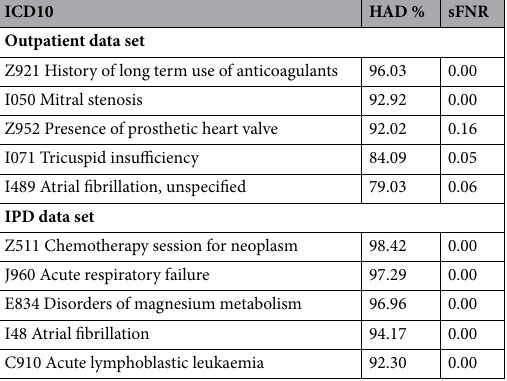
Table 11. Top 5 the highest HAD percent with specific false negative ratio (sFNR).